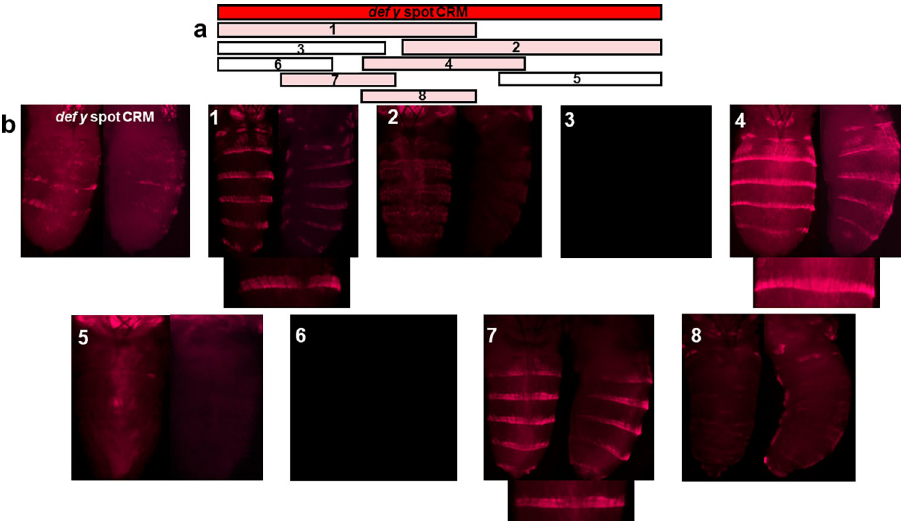
Fig 8. The orthologous D . deflecta region ( def y spot CRM) analyzed in transgenic D . guttifera . a, A schematic of the orthologous def y spot CRM is shown as a solid red bar. The rectangular bars (1–8) under the red bar represent the sub-fragments of the def y spot CRM that were tested for reporter activity. The sub-fragments that drove reporter expression are highlighted in pink, whereas the constructs that did not show any pattern are shown as rectangular white bars. b, The pupal DsRed expression patterns of the sub-fragments are shown in transgenic D . guttifera during stage P10. For sub-fragments #1, #4 and #7, an additional image focusing on a single stripe is shown below the abdominal images that show horizontal stripes on the abdomen. Sub-fragment #7 shows the orthologous minimal def y stripe core CRM. The reporter expression is detected in horizontal stripes but absent along the dorsal